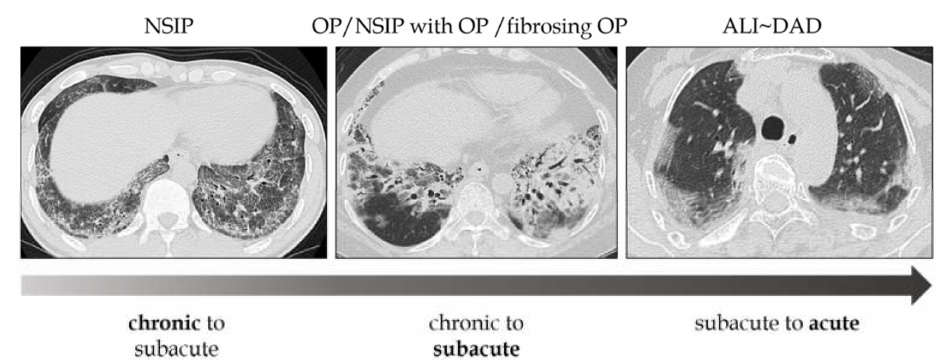
Figure 2. Relationship between morphologic patterns and the types of onset. The phenotypes of these lesions are difficult to distinguish clearly, given that varying degrees of inflammation and lung injury exist on the same spectrum. NSIP: nonspecific interstitial pneumonia, OP: organizing pneumonia, ALI: acute lung injury, DAD: diffuse alveolar